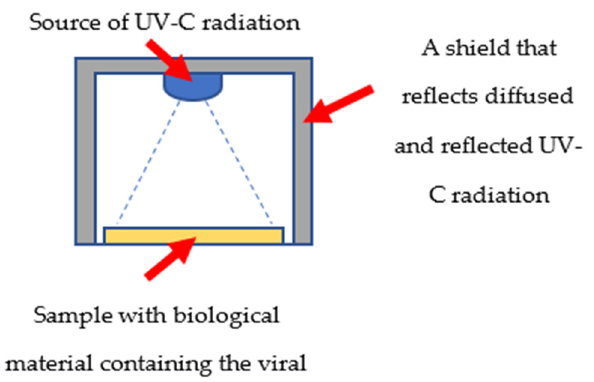
Figure 1. A schematic graphic diagram showing the illumination process and the signal that falls on the virus pan .